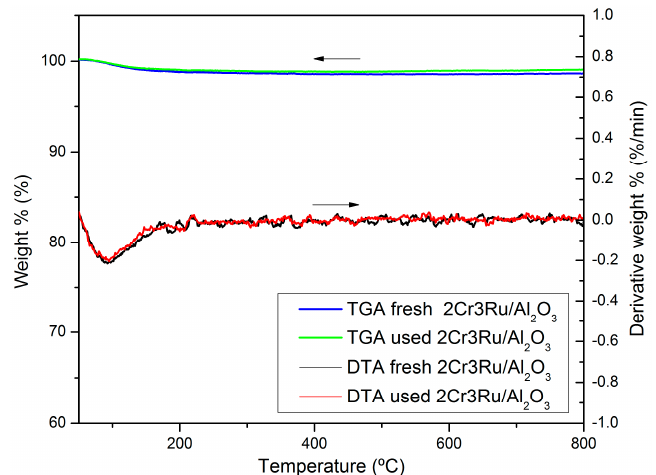
Figure 11. Time-on-stream testing results of 2Cr3Ru/Al 2 O 3 catalyst during 24 h. Reaction conditions: